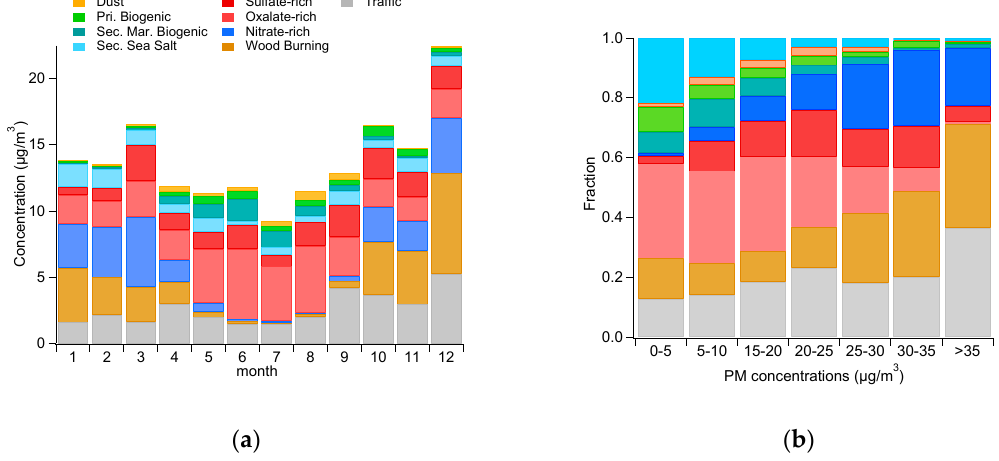
Figure 2. ( a ) Monthly average of the 9 PMF factors over the whole campaign; ( b ) Mean contribution of each PMF factor for different PM 10 loadings (from 0 to 35 µg/m 3 , with a step of 5 µg/m 3 ).